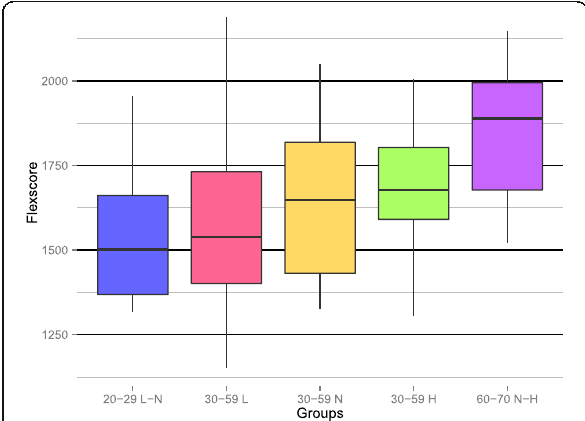
Fig. 5 FlexScore distribution per study group. Box shows the interquartile range (IQR) with the median. The line indicates the range of observations within the ± 1.5 × IQR. Groups labeling used the respective age intervals as well as their body fat percentage intervals, L for low, N for normal, and H for